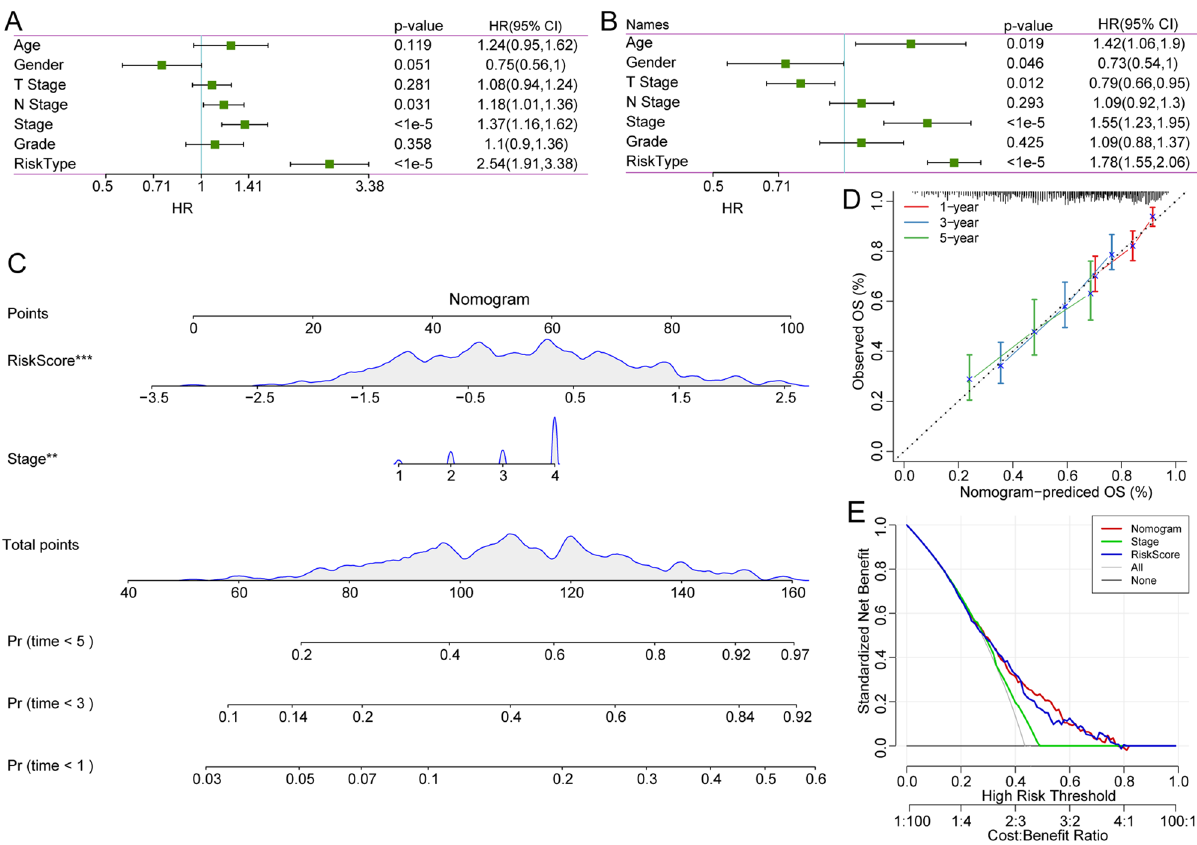
Figure 8. Construction of the nomogram for predicting the prognosis of HNSCC patients in the TCGA-HNSC cohort. Univariate Cox regression analysis ( A ) and multivariate Cox regression analysis ( B ) showed that the seven-gene signature was an independent risk factor. ( C ) Nomogram constructed by the risk score and stage in HNSCC patients. ( D ) Survival rate correction curves of the nomogram. ( E ) DCA curves of the nomogram, stage, and risk score showed that the nomogram had good predictive